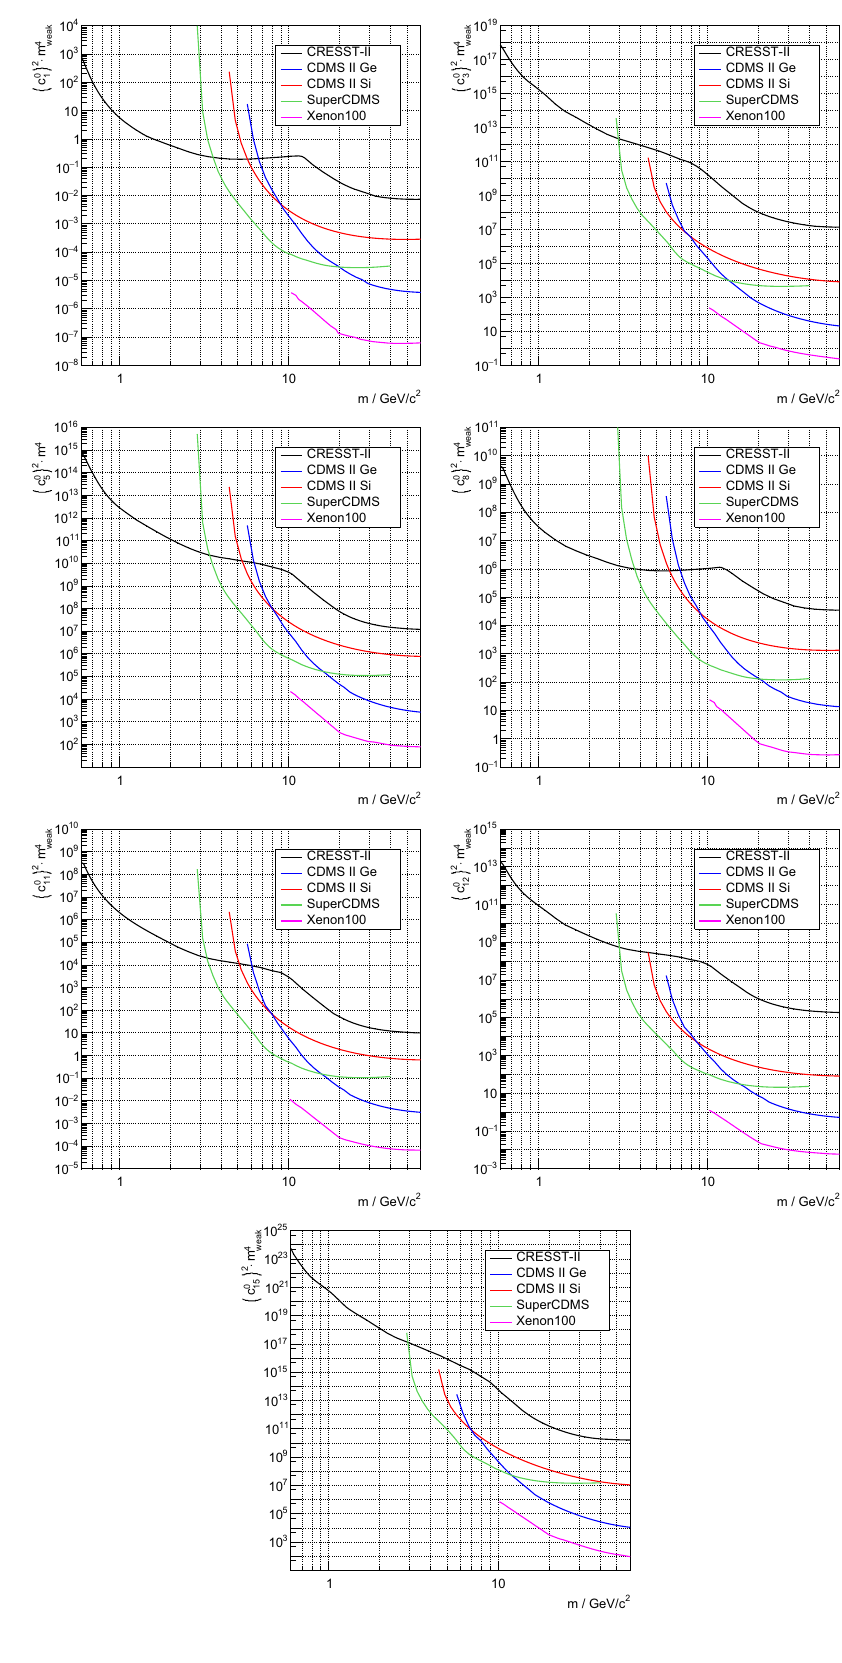
Fig. 3 Upper 90% limits for the Wilson coefficients c 0 , c 0 , c 0 , 1 3 5 c 0 , c 0 , c 0 and c 0 as a function 8 11 12 15 of the dark matter particle mass (black), compared to results from Xenon [18] (magenta) and CDMS [17] (other